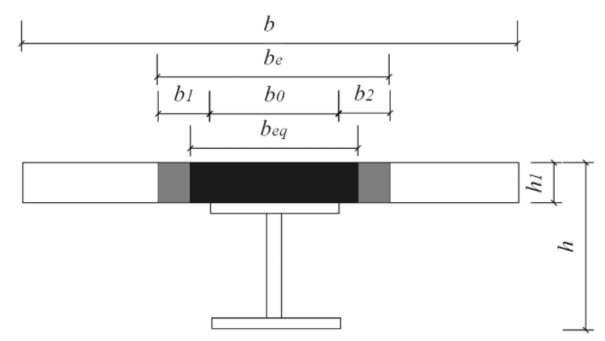
Figure 20. Effective width and conversion